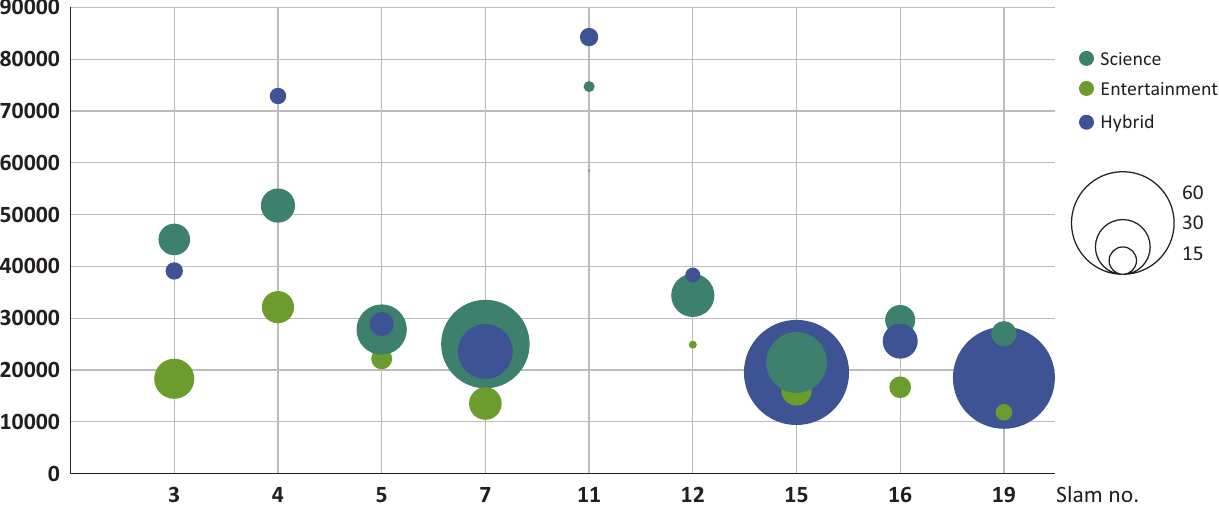
Figure 4. Average visibility of the elements attributed to the three AOI categories in 9 different science slam presentations. Notes: The numbering corresponds to that in Figure 2. The size of the circles denotes the number of elements in a